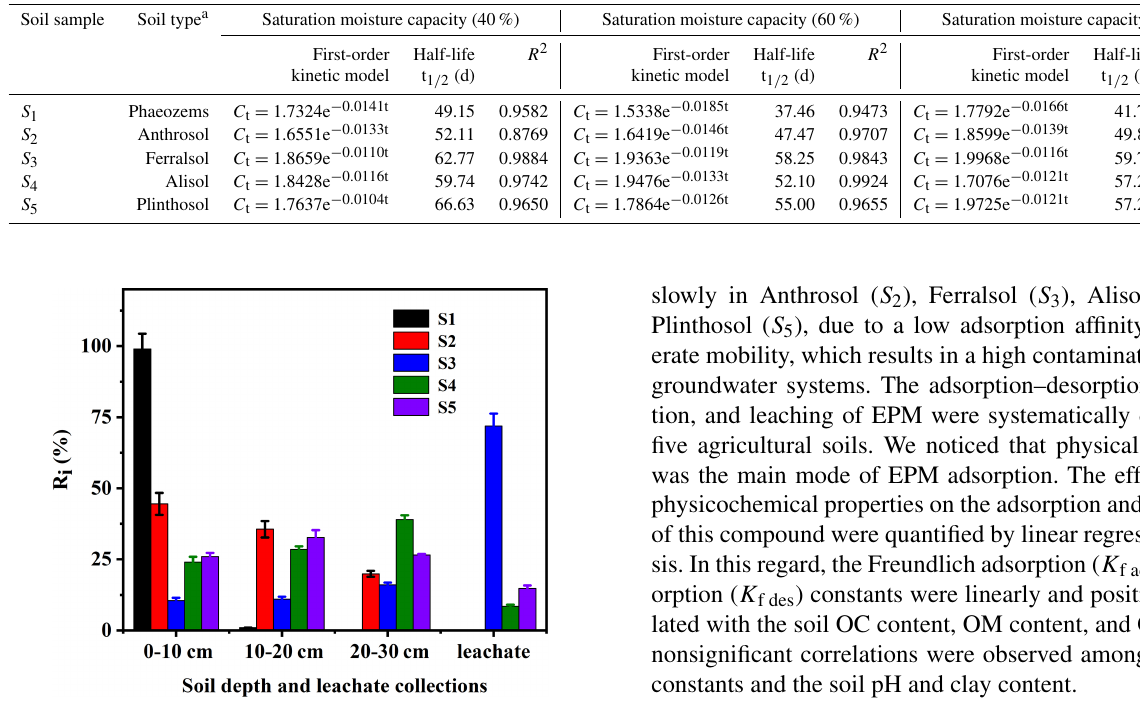
Figure 3. Distribution of EPM in soil column and leachate of five different agricultural soils ( S 1 to S 5 are defined in Table